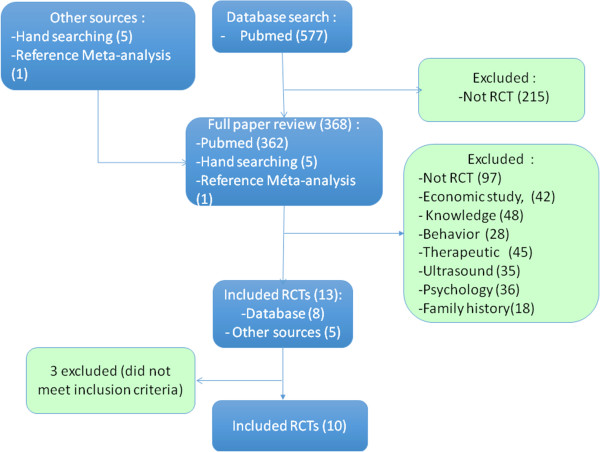
Flow diagram of included studies. RCT, randomized controlled trial.